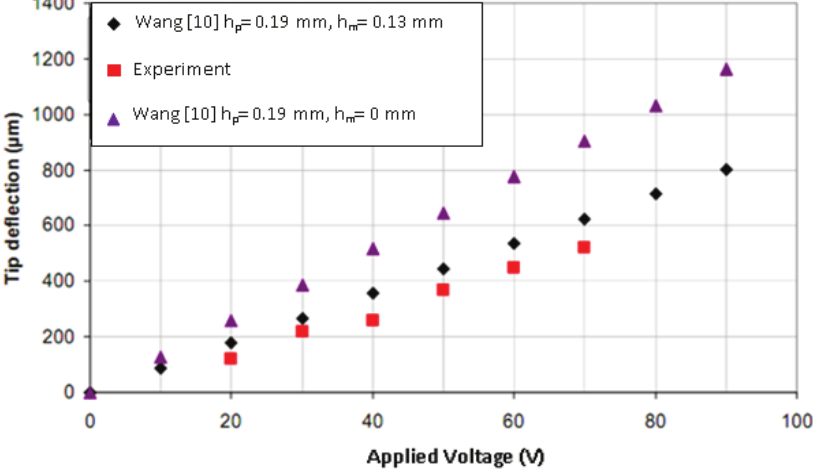
: thickness of the supporting layer m